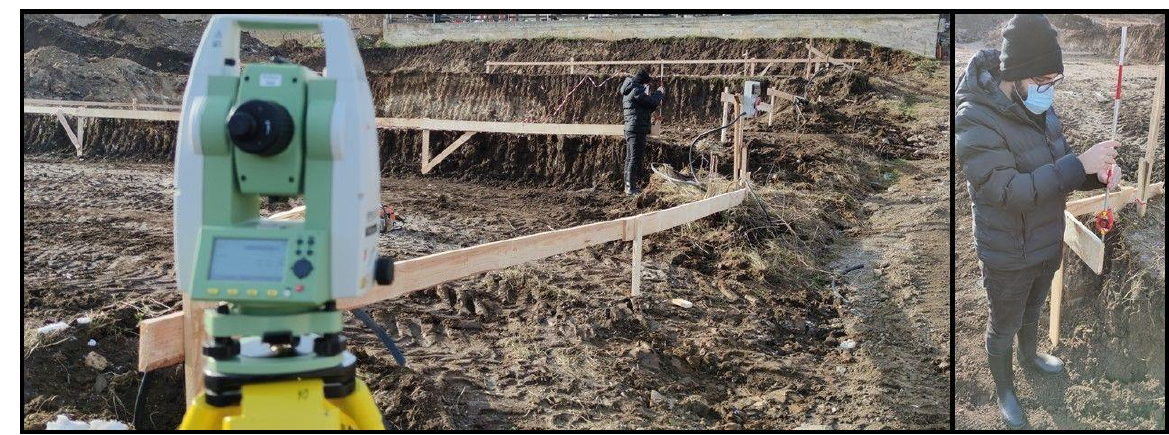
Figure 10. Batter boards survey.